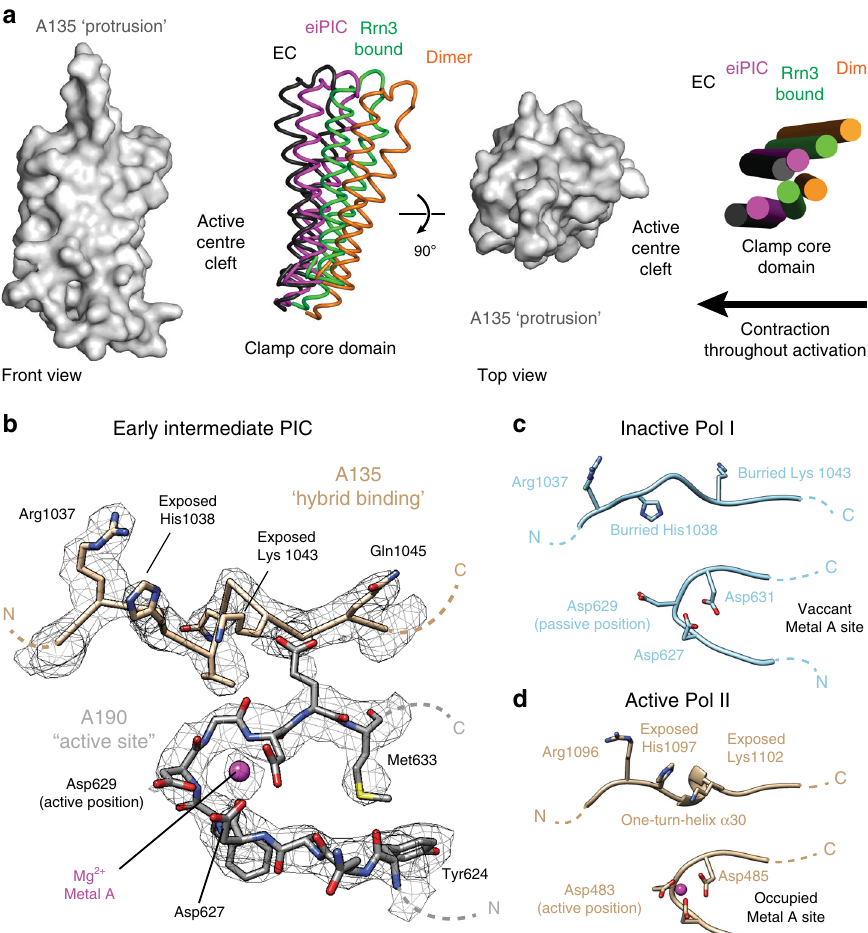
Fig. 4 Pol I is primed for initiation in the eiPIC. a Cleft contraction throughout activation stages. Pol I structural models were overlaid via their A135 subunits (protrusion subdomain in gray, space fi lling). Cleft contraction is indicated by colored clamp core helices (subunit A190). Monomeric Pol I and ITC stages are similar to Rrn3-bound- and EC-conformations, respectively (not shown for clarity). PDB models displayed: 4C2M (orange), 5G5L (green), eiPIC (magenta) and 5M3F (black). b Atomic model of the active center and hybrid-binding domains within Pol I subunits A190 and A135, respectively. Overlaid with sharpened eiPIC density (gray mesh). The metal A site is occupied and a one-turn-helix α 30 is formed in A135, exposing positively charged residues. c Inactive Pol I (PDB 4C2M) region for comparison to b . d Active Pol II region for comparison to b and c